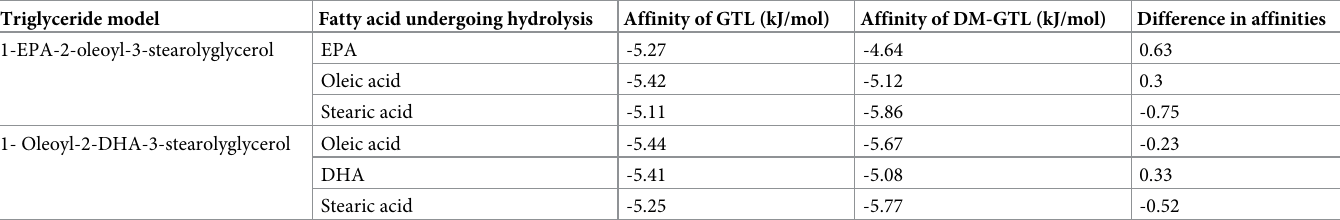
Affinities of GTL and DM-GTL towards hydrolysis of different fatty acids. Affinity of a fatty acid is calculated to be the binding energy between the representative substrate and enzyme when that fatty acid is undergoing